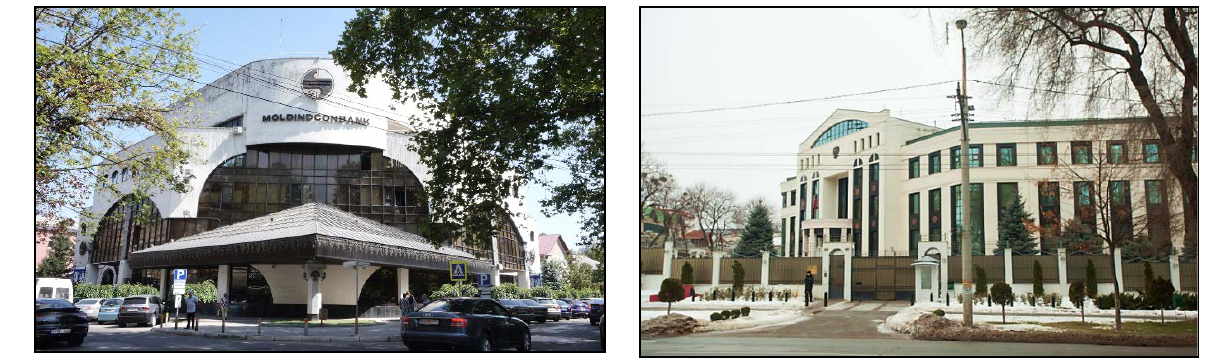
Figure 12 . The Moldindconbank, 1995. Figure 13. The Embassy of RF, 1999.